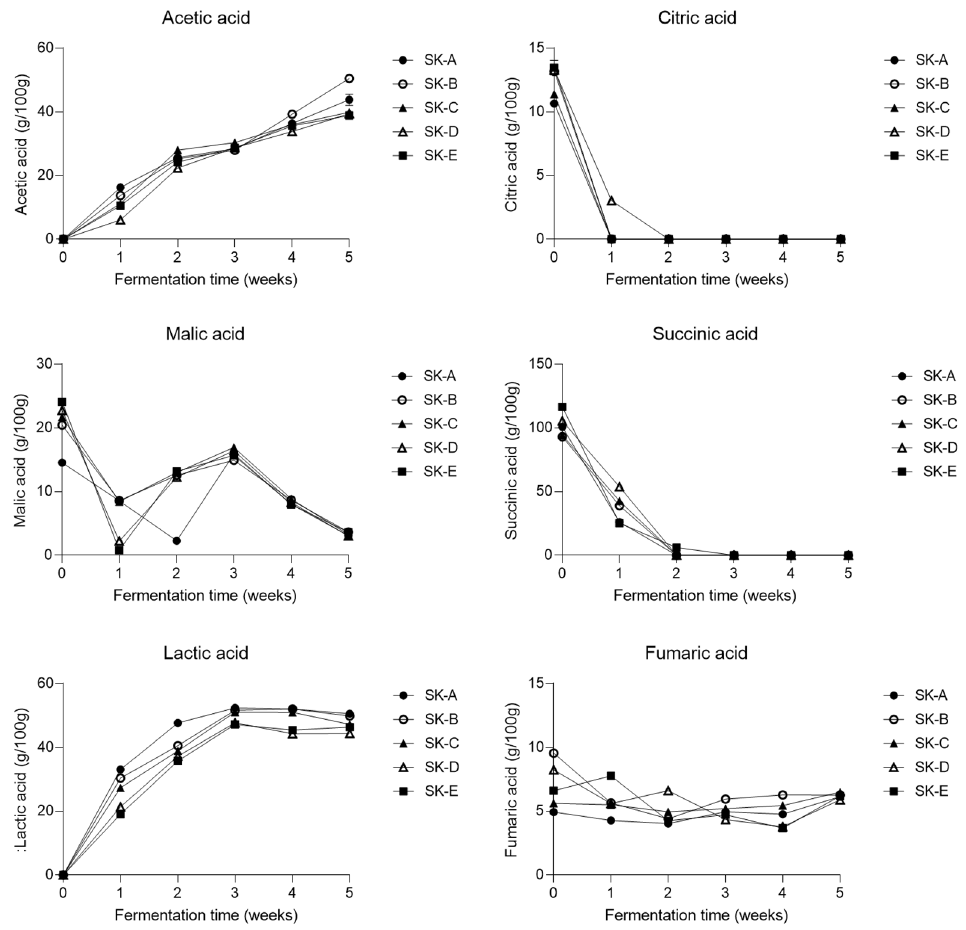
Figure 3. Changes in the organic acid contents of kimchi samples with different salinities during fermentation.